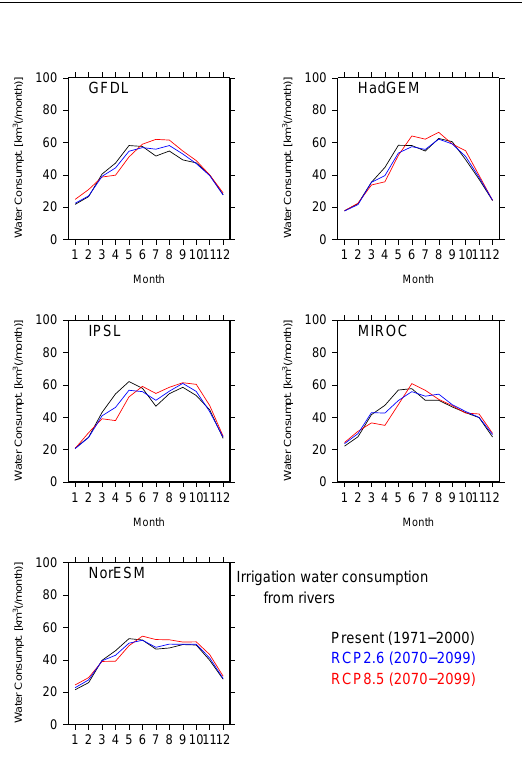
Figure 12. Monthly profiles of the global sum of irrigation water consumption from rivers (IWCR) for the reference and sensitivity experiments with artificial biases of ± 5%RH. The analysis period is 1971–2000. although the range is increased in June and July (110 and 102 %, respectively).